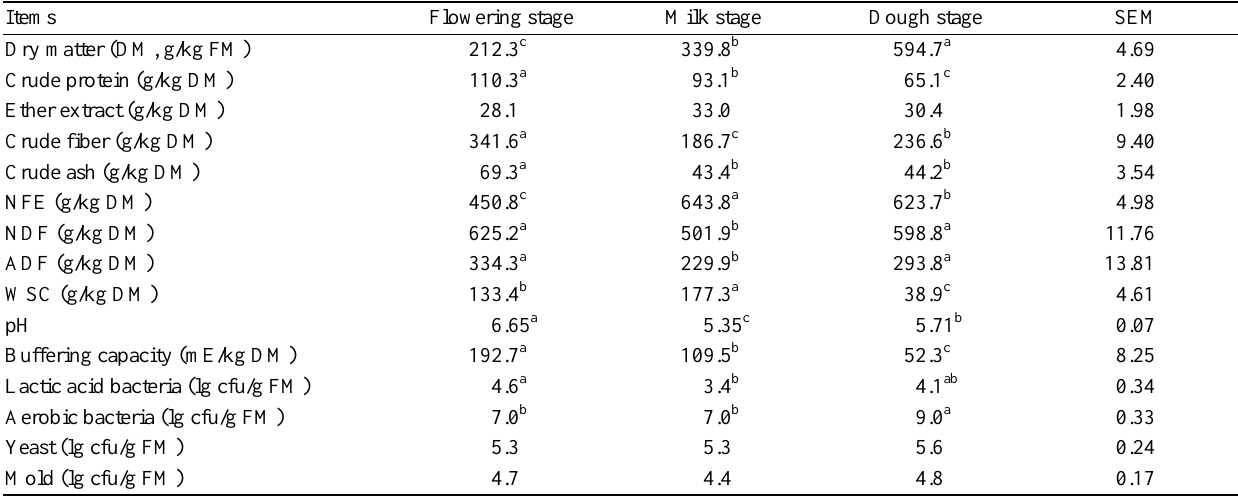
Table 2. The chemical and microorganism composition of wheat harvested at different stages prior to ensiling Items Flowering